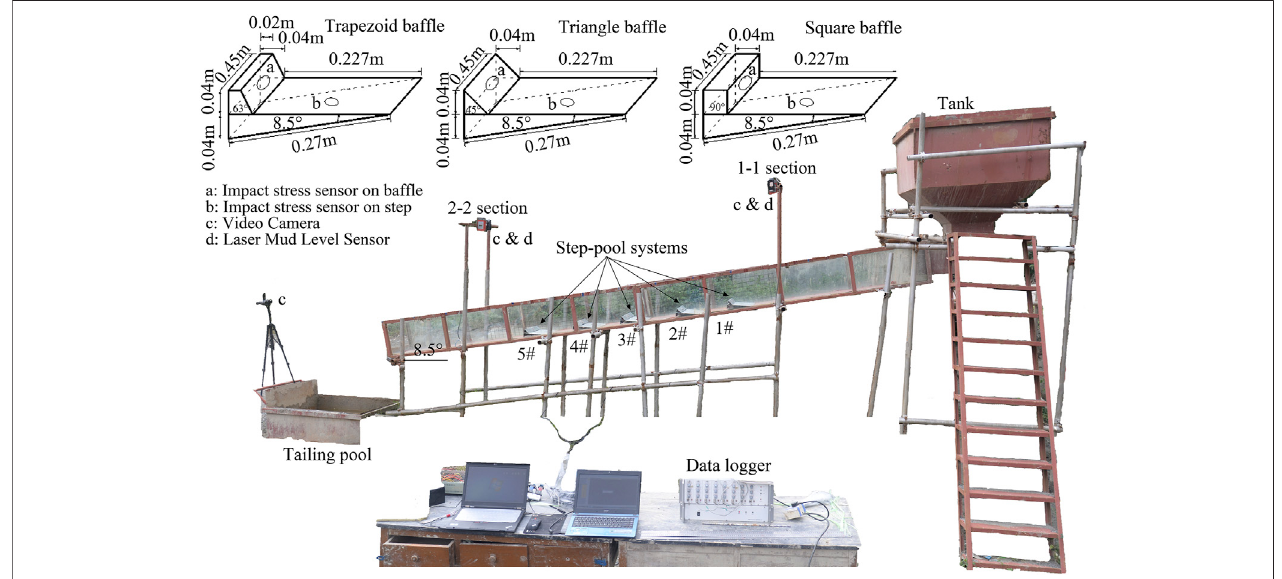
FIGURE 3 | Schematic diagram of the test equipment, baf fl e con fi gurations and impact pressure measurement points.